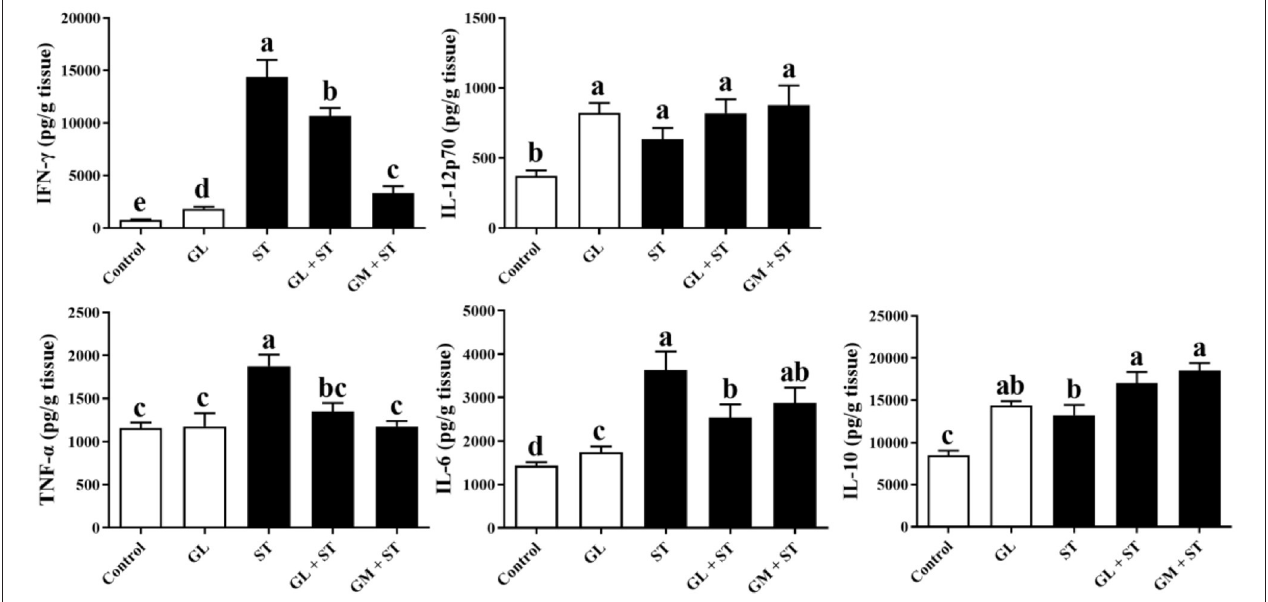
FIGURE 4 | Effect of GL on splenic cytokine production in ST-infected mice. The levels of pro-inflammatory cytokine (IFN- γ , IL-12p70, TNF- α , and IL-6) and anti-inflammatory cytokine (IL-10) in spleen were determined by ELISA kit. Results are presented as mean ± SD ( n = 5/group). Different lowercase letters indicate a significant difference ( P < 0.05).